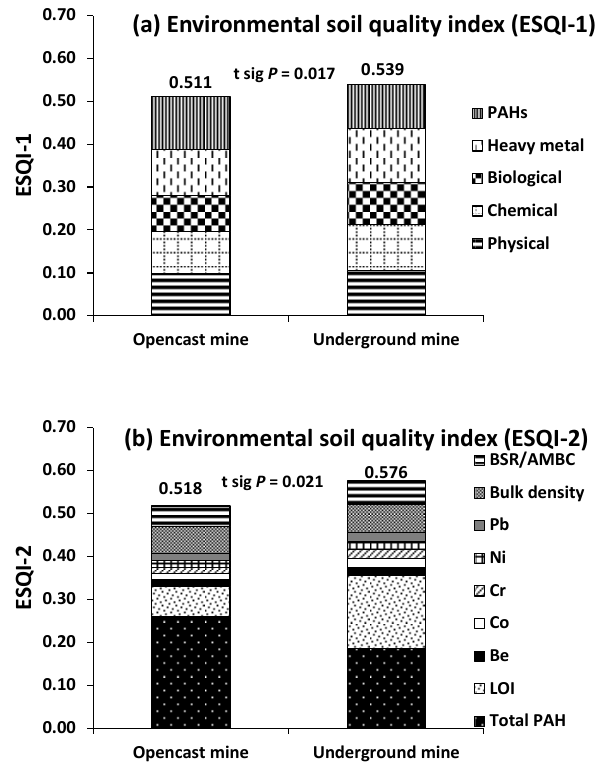
Figure 2. Environmental soil quality index of opencast and under- ground mine soils by (a) unscreened transformations (ESQI-1), and (b) principal component analysis-based index